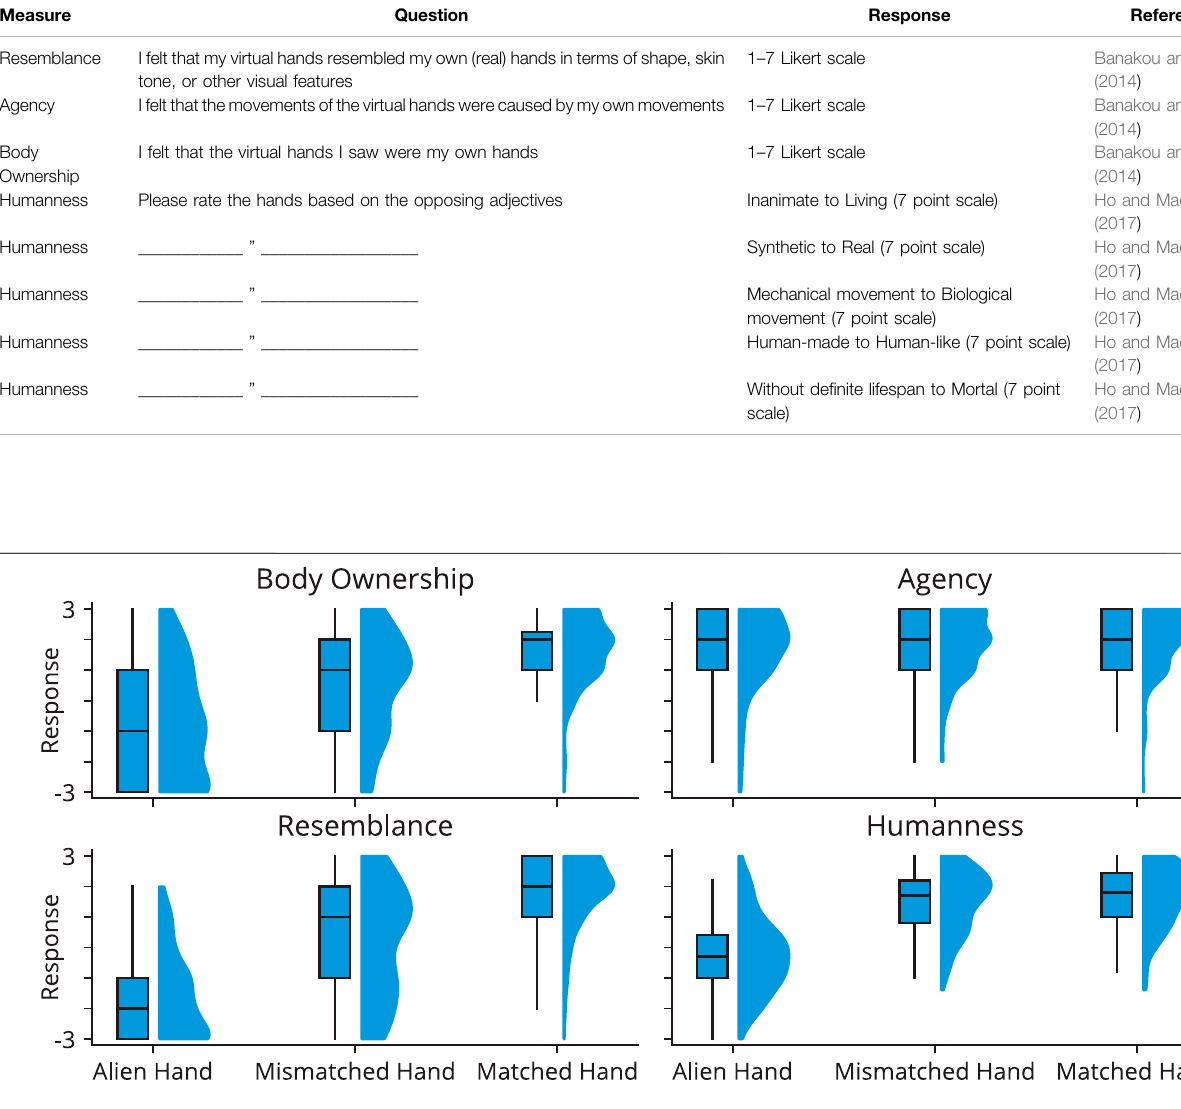
FIGURE 2 | Participants ’ responses to the four subjective measures we used for validating our hand texture dateset. Responses range from -3 (strongly disagree) to 3 (strongly agree), humanness shows aggregated scale based on fi ve such responses.